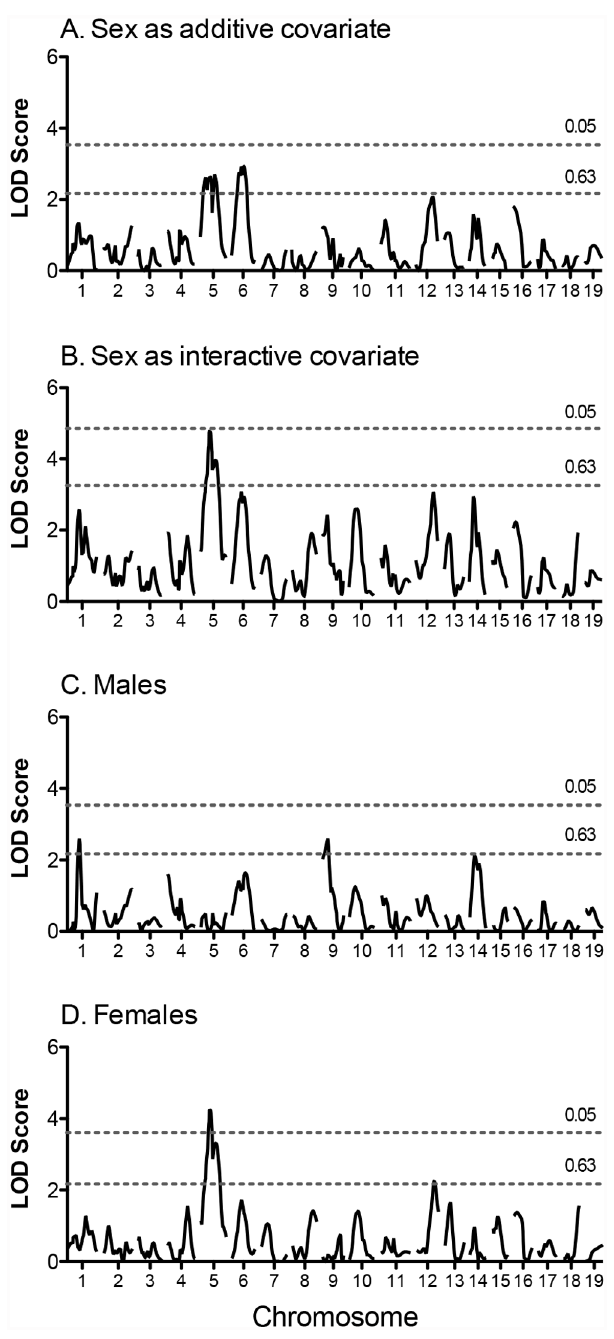
Fig 1. Genome-wide scan for pre-training exercise time in (NZW x 129S1) F 2 mice. Scans were performed for the entire population with “ sex ” as an additive covariate (A) or interactive covariate (B), and in males (C) and females (D) separately. Horizontal lines represent significant (P = 0.05) and suggestive (P = 0.63) logarithm of odds (LOD) thresholds, respectively. LOD thresholds were determined by permutation testing using 1000